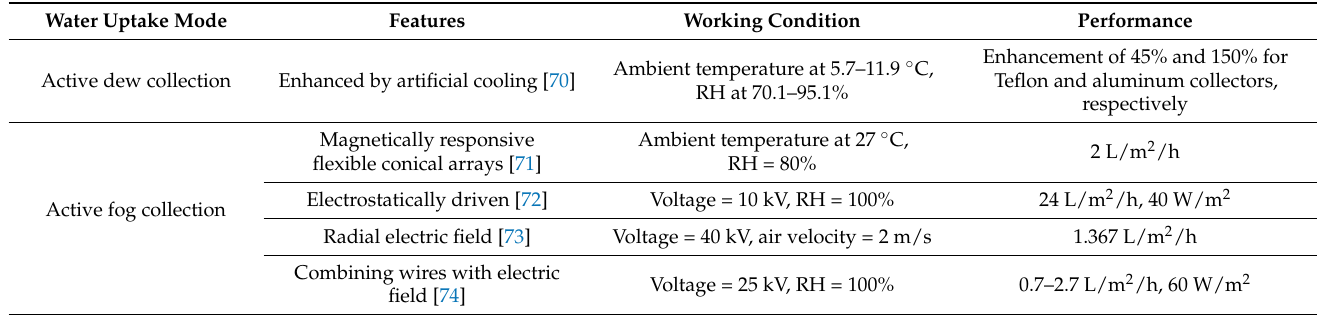
Table 3. Features and parameters of selected active fog-dew water harvesting systems.